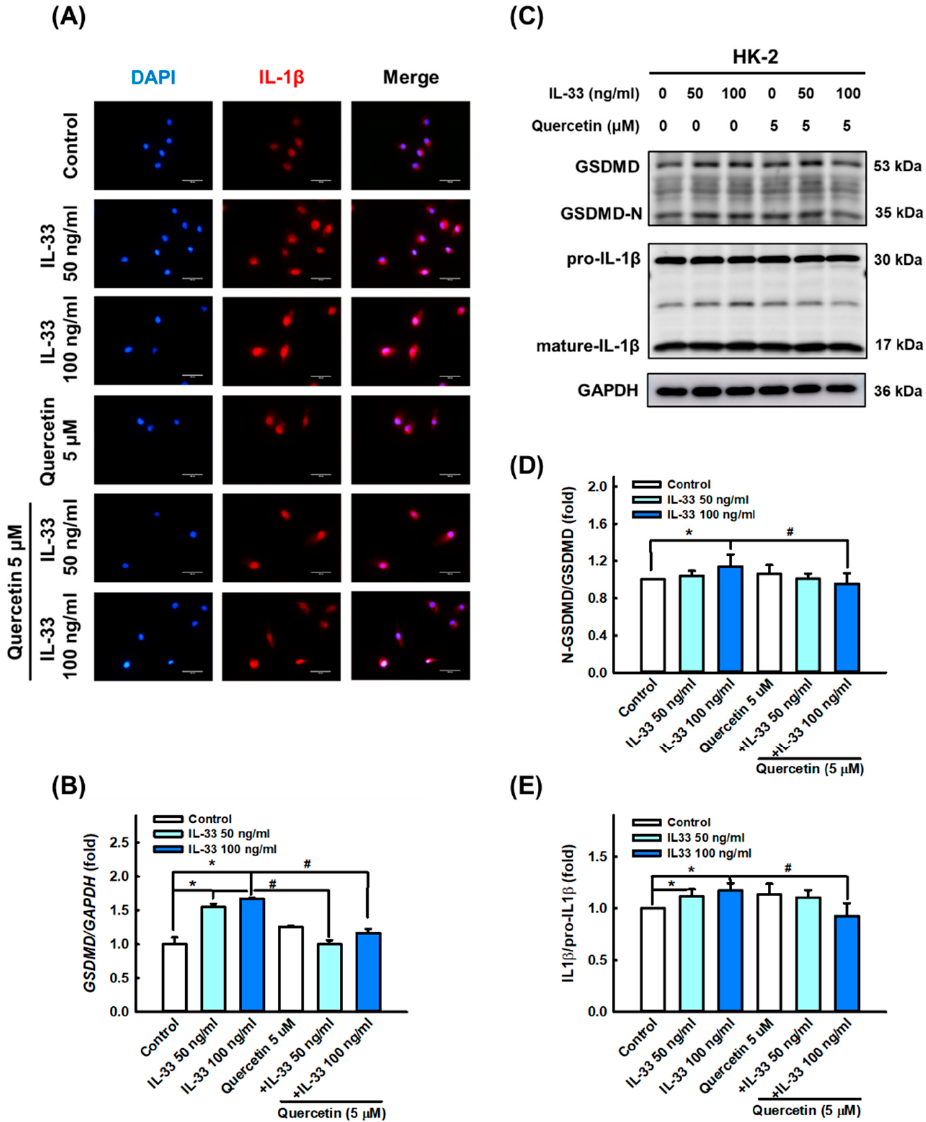
Figure 5. Quercetin reduced pyroptosis-associated proteins expression in human renal tubular epithelial cell line. HK-2 cells were co-cultured with 5 μ M quercetin and 50 ng/mL or 100 ng/mL recombinant human IL-33 for 48 h. ( A ) Representative photomicrographs showing the immunofluorescence staining for IL-1 β (red) among different groups. Magnification, 400 × . ( B ) Quantitative histograms showing the results of qPCR analysis for GSDMD mRNA level. ( C – E ) Immunoblots and quantitative histograms showing the results of Western blotting analysis for the expression of GSDMD and IL-1 β protein. Data are expressed as mean ± SD ( n = 3). * p < 0.05 versus control group; # p < 0.05 versus corresponding IL-33-stimulated group.